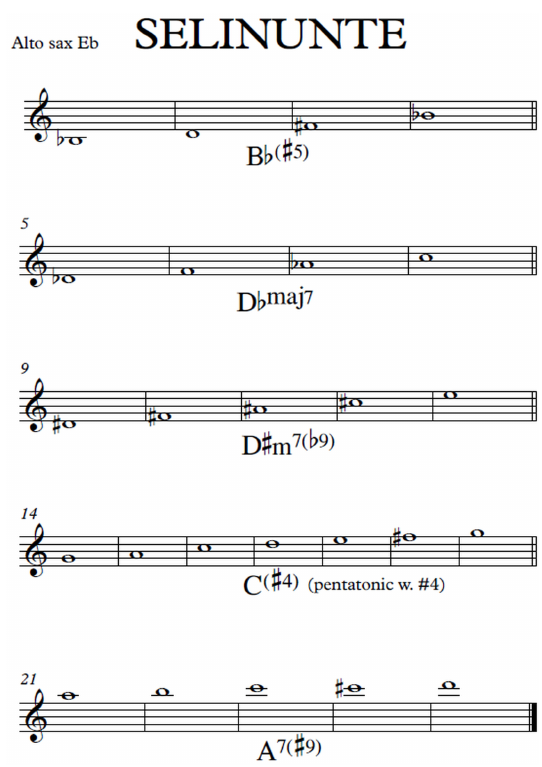
Figure 4. Score of the Selinunte